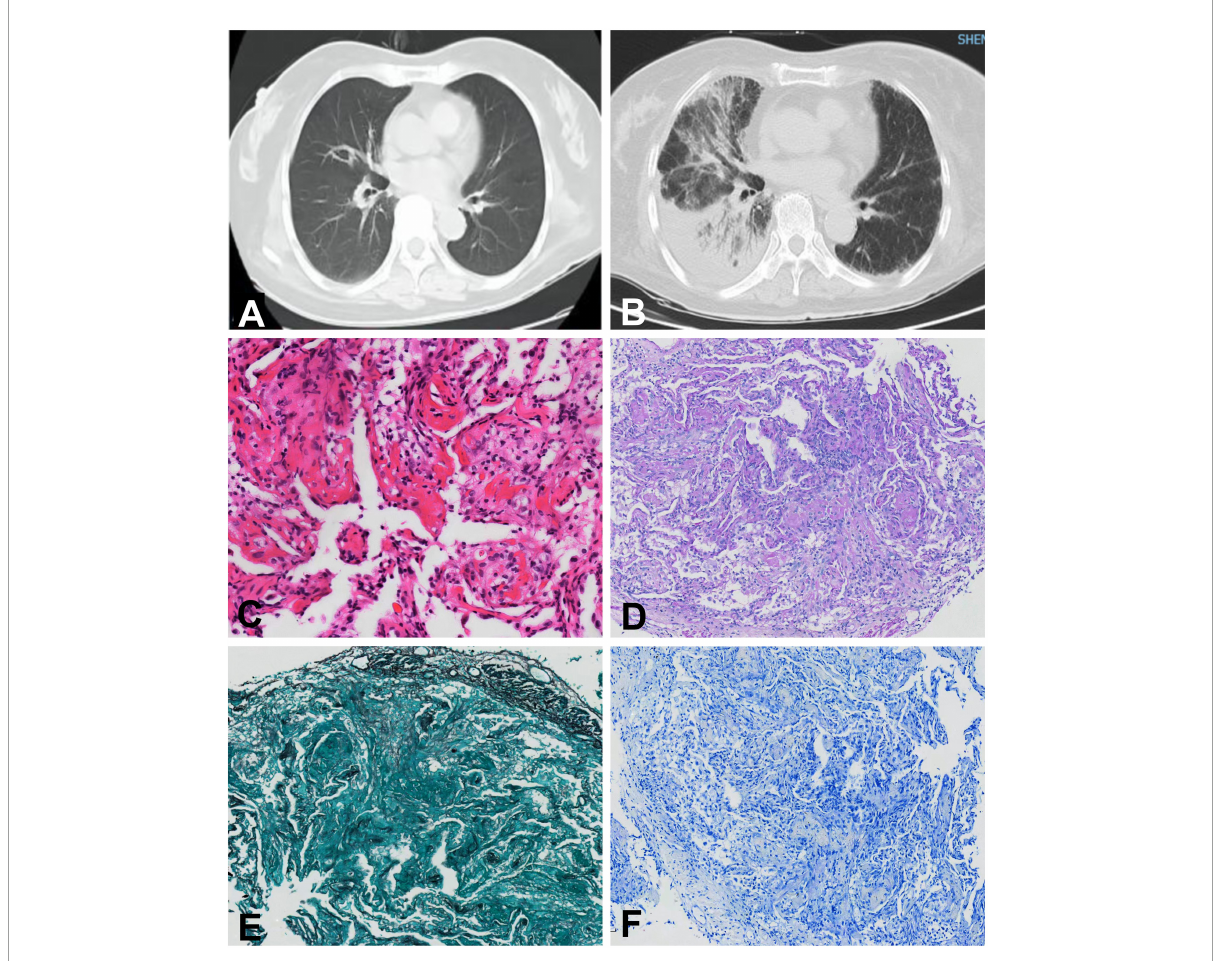
FIGURE2 Chest computed tomography and histopathological changes of the lung biopsy in case 2. Chest computed tomography before (A) and after (B) onset of pneumonia. (C) Hematoxylin-eosin staining ( × 20). (D) Periodic acid-Schiff staining ( × 10). (E) Hexosamine silver staining ( × 10). (F) Antacid staining ( ×